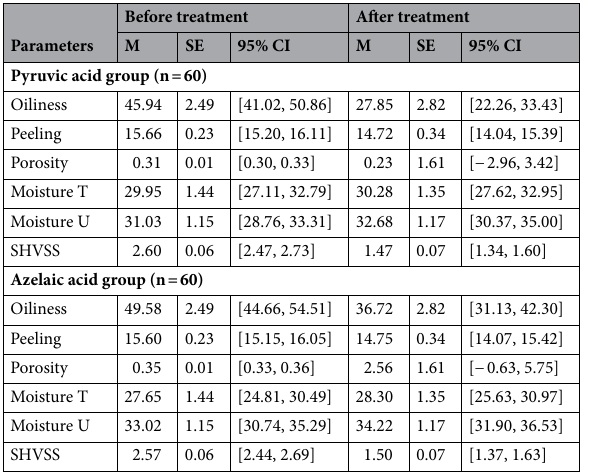
Table 1. Comparison of the mean scores for skin parameters during 12 weeks of azelaic and pyruvic acid treatment.